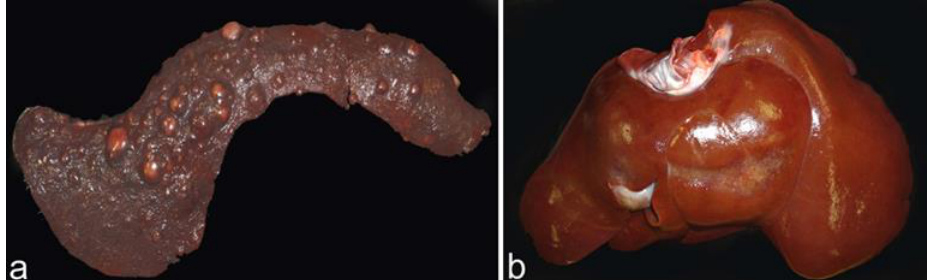
Figure 7. Liver and spleen from dog 3. ( a ) Mildly enlarged spleen with multifocal tan to whitish nodular lesions. ( b ) Enlarged liver with a marked depression, of fibrotic appearance, in the medial lobe.